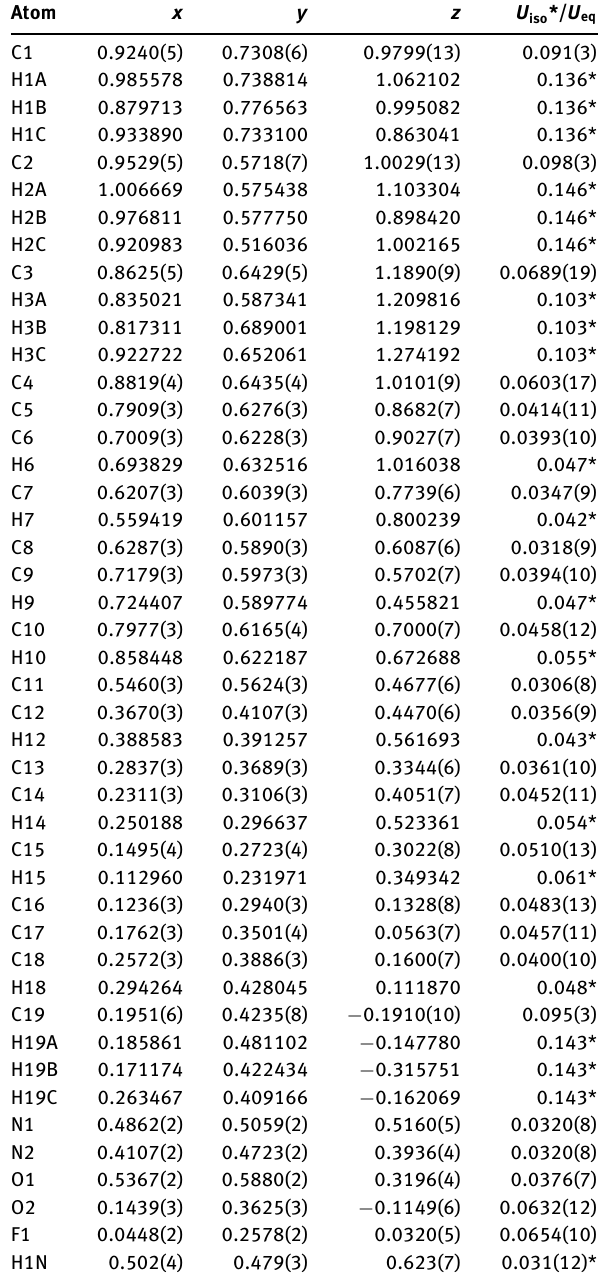
Table 2: Fractional atomic coordinates and isotropic or equivalent isotropic displacement parameters (Å 2